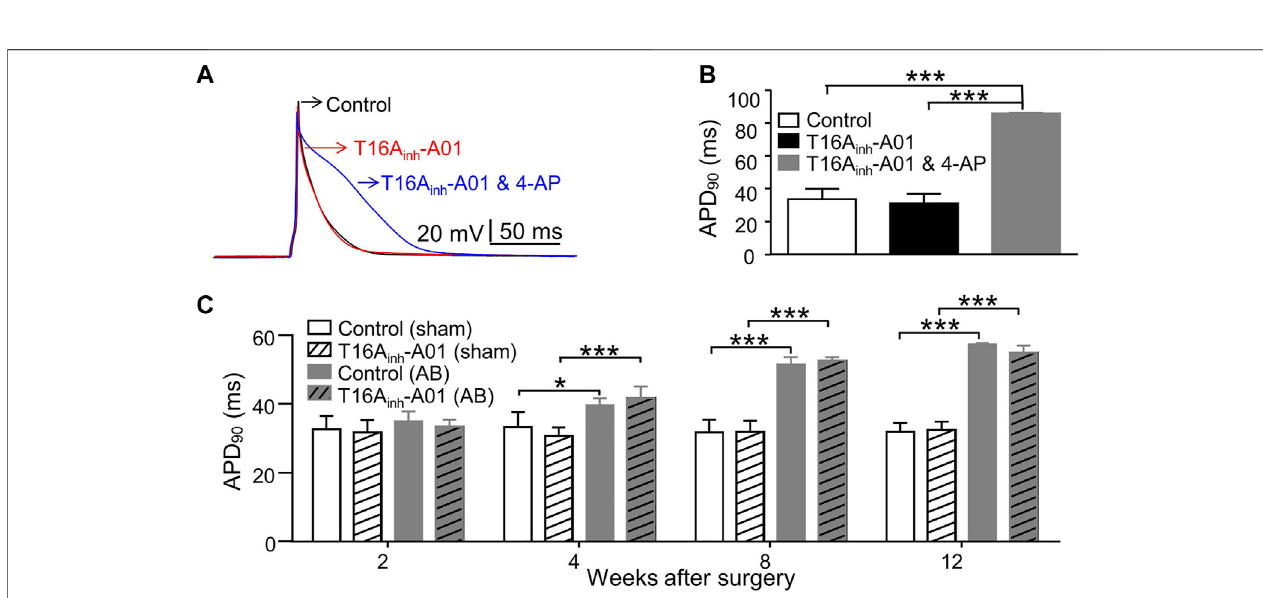
FIGURE 4 | AP in LVMs. (A) Superimposed APs were recorded from the same cell before (control), after exposure to T16A inh -A01 (30 μ M), and after exposure to T16A inh -A01 (30 μ M)and 4-AP (5 mM). (B) Bargraphsshow averageAPD 90 inLVMs under conditions described above ( n =4cells, *** p < 0.001,one-wayANOVA). (C) Bar graphs show average APD 90 in LVMs of mice after surgery (n = 7 — 8 cells from three mice in each group per time point, * p < 0.05 and *** p < 0.001, RM two-way